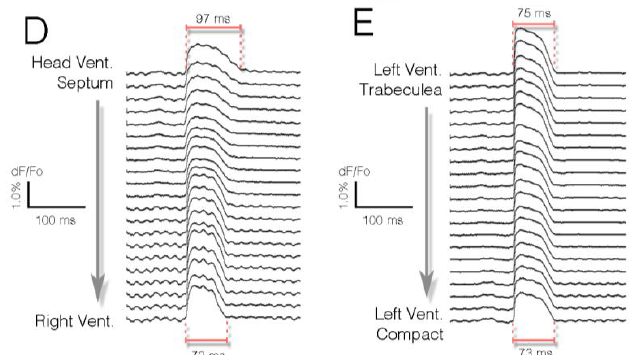
Figure 2. Optical mapping allows for integrative, simultaneous acquisition of physiological parameters from multiple points in situ. ( A ) Time series of electrical impulse propagation through a section of embryonic cardiac tissue. In this example, a Hamburger and Hamilton (HH) stage 30 [41] embryonic chick heart was sectioned in the coronal plane and live imaged at 2000 frames per second. Activation of the right bundle branch (red arrowheads) can be seen; ( B ) Isochronal map (1 ms/div) depicting the ventricular activation pattern of the heart from ( A ); ( C ) Intensity plot indicating relative signal amplitude (dF/Fo) for heart in ( A ); ( D ) Stripe analysis from region noted in ( B ). These data track the change in action potential shape as the impulse moves from the His bundle towards the right ventricle. Note that action potential duration decreases; ( E ) As in ( D ), tracing of action potential characteristics as it propagates from left ventricular trabeculae to compact myocardium.